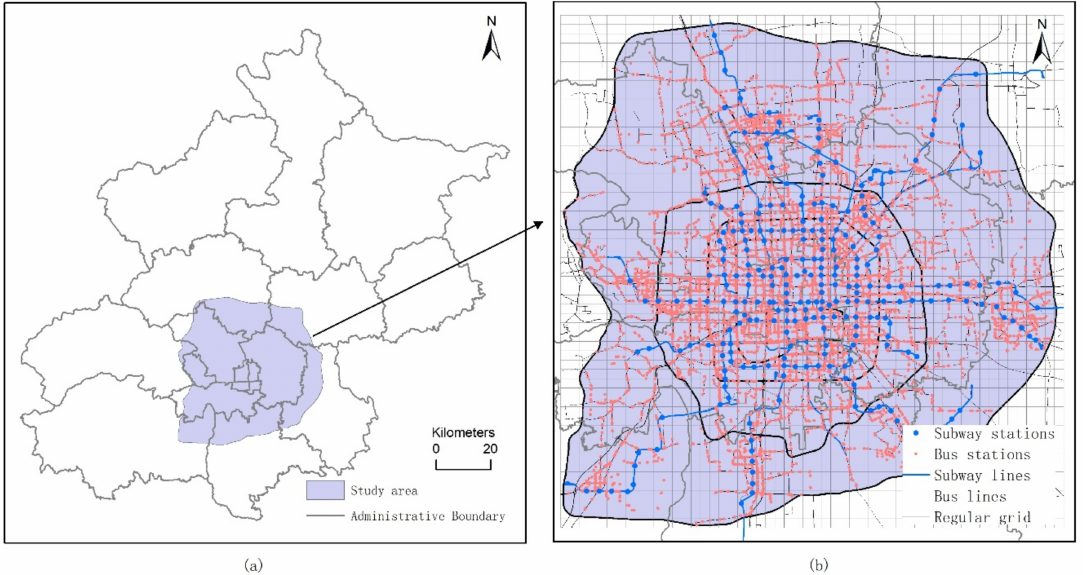
Figure 1. Case study area: ( a ) Beijing; ( b ) sixth ring road of Beijing.